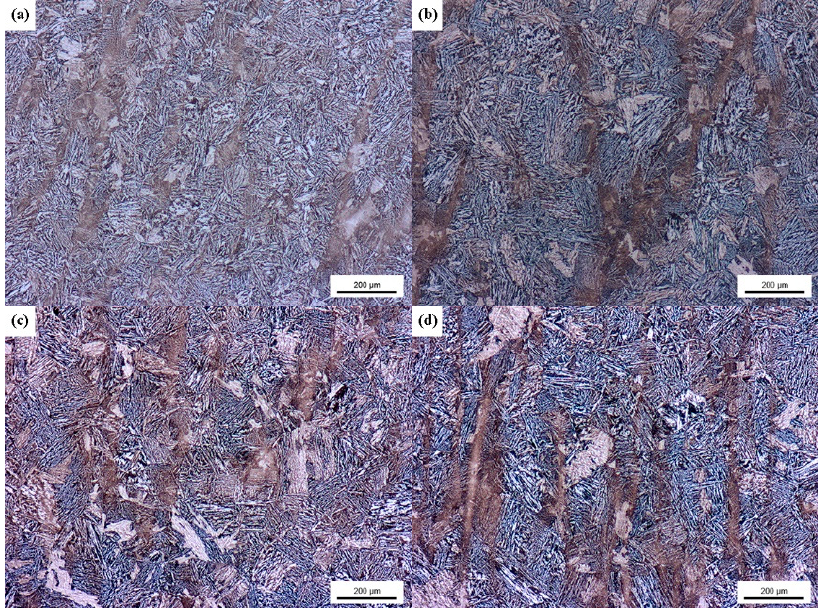
Figure 11. Effect of the void long and short axis ratio on the void healing rate. Since the phase-field method uses dimensionless parameters, the simulation results in Figure 11 are also dimensionless.